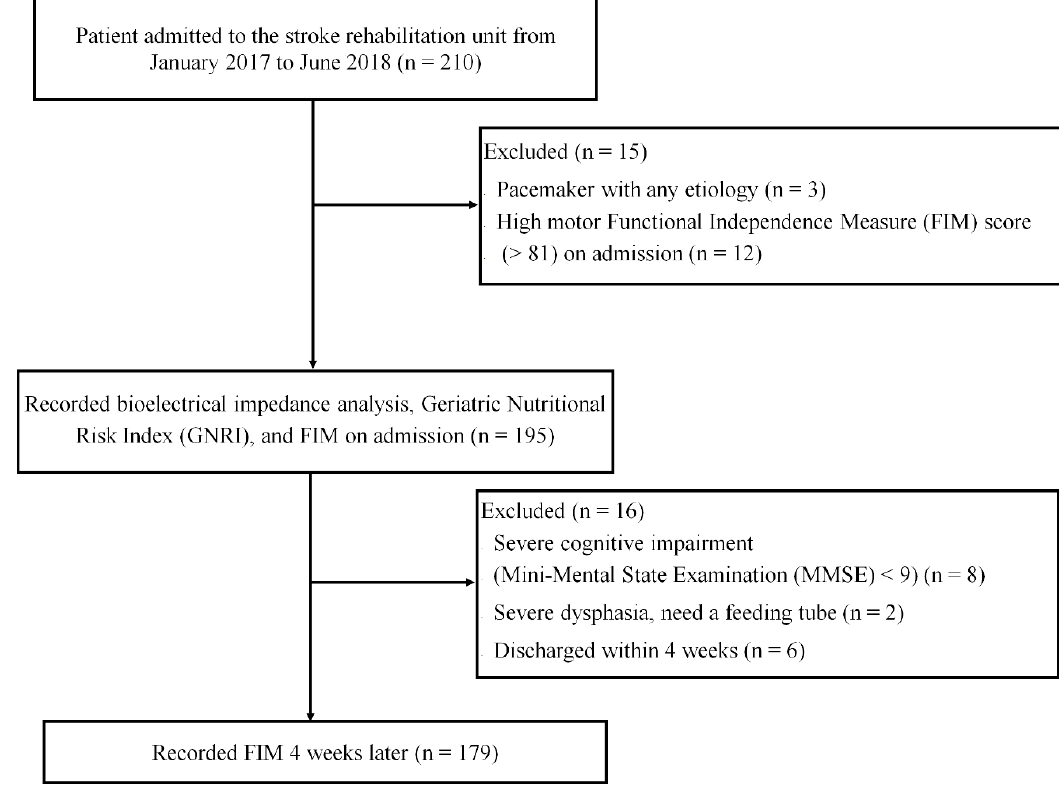
Figure 1. Flowchart outlining the inclusion and exclusion criteria and study design. The study included 210 consecutive patients with stroke. Patients with a pacemaker, a high ADL score, severe cognitive impairment, severe dysphasia, and early discharge were excluded from the study.